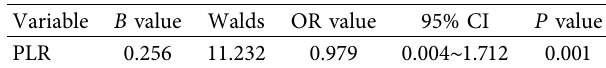
Table 4: Multivariate logistic analysis on affecting the prognosis of patients with